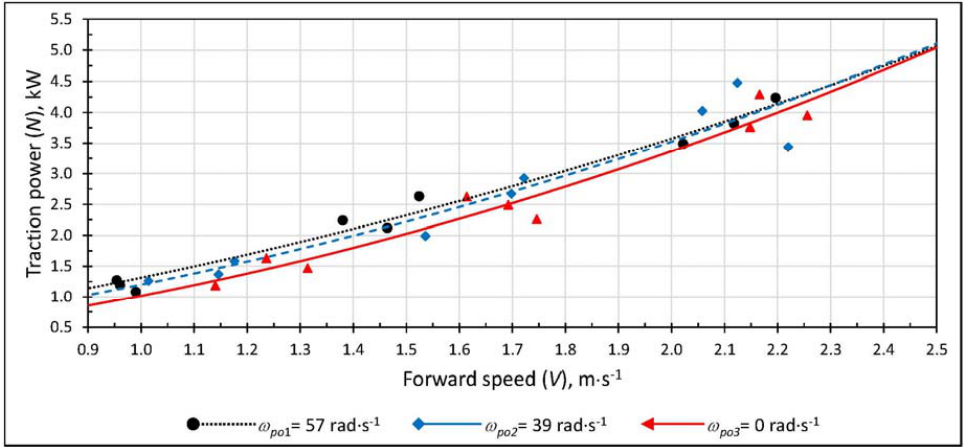
Figure 6. Tractor traction power N vs. aggregate tractor – beet top harvester forward speed V for different values of screw conveyor drive shaft angular speed.